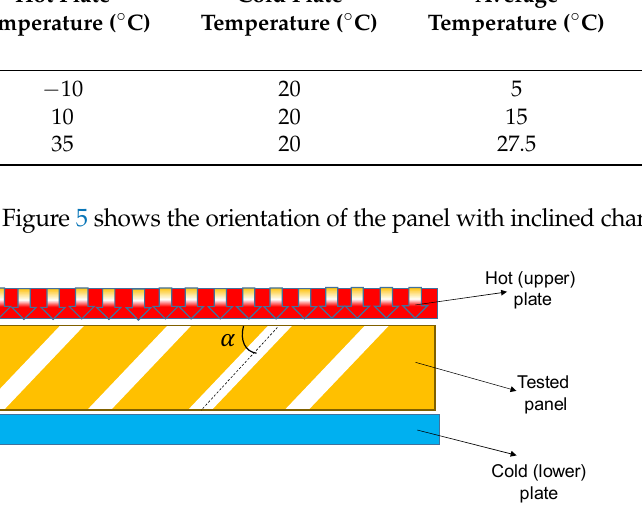
Figure 5. Orientation of the panel with inclined channels in the heat flow meter (P4—panel with perforated inclined channels with an angle α = 45°).